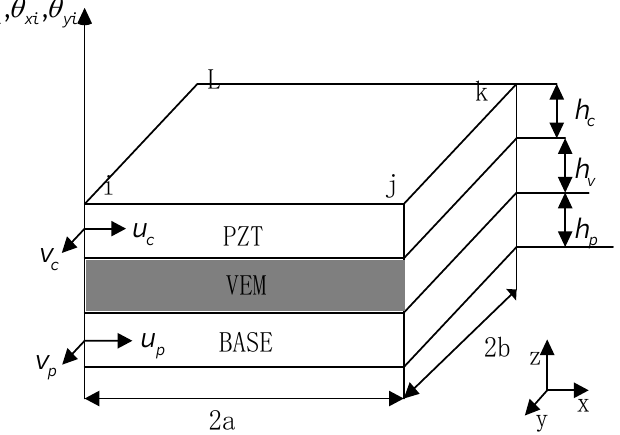
Figure 3. Schematic diagram of sandwich plate unit and local coordinates.